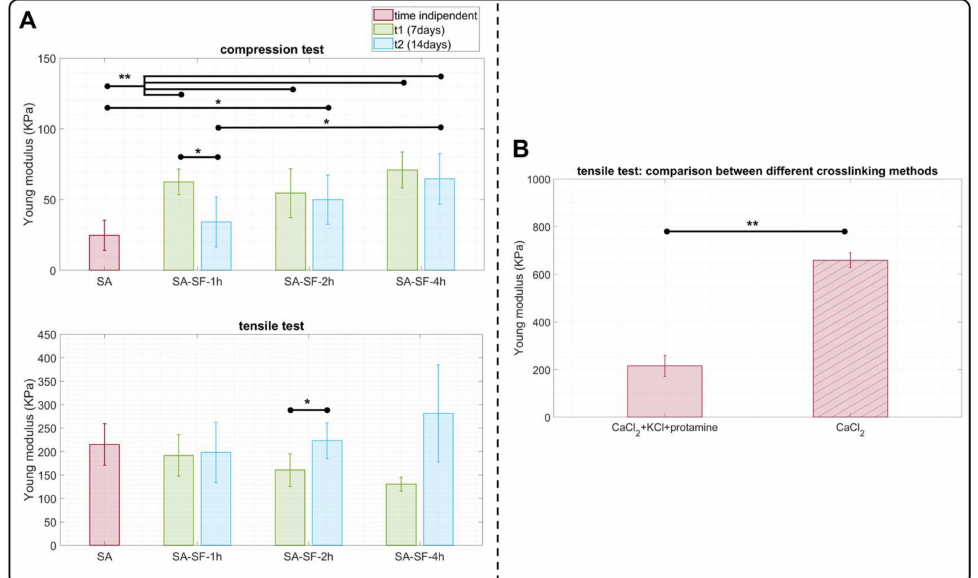
Figure 5. Mechanical characterization: ( A ) compressive and tensile results performed on SA hydrogel (control) and SA-SF hydrogels at 7 and 14 days from preparation of the silk-fibroin solution; ( B ) tensile analysis performed on SA hydrogels treated with CaCl 2 + KCl + protamine solution and CaCl 2 solution only. Data are reported as mean values ± SD. The number of samples for each condition is specified in Materials and Methods (Section 2.5.1). * p < 0.05, ** p < 0.01.